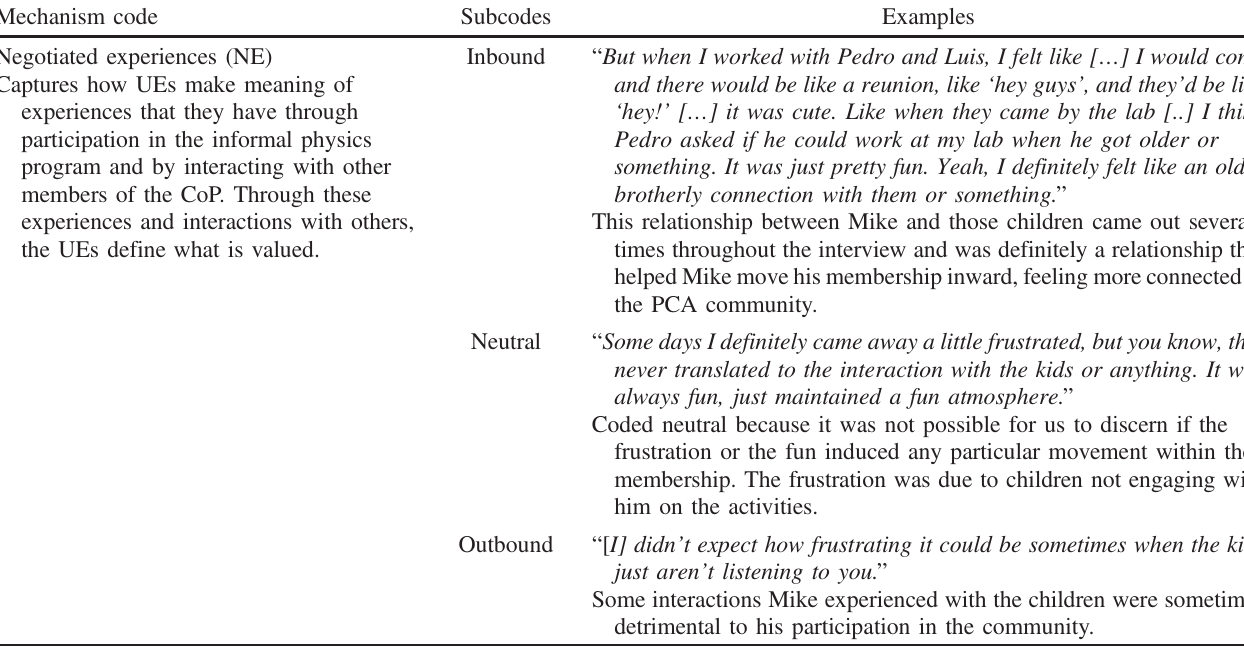
TABLE VI. Examples and explanations for each subcode under the negotiated experiences construct.